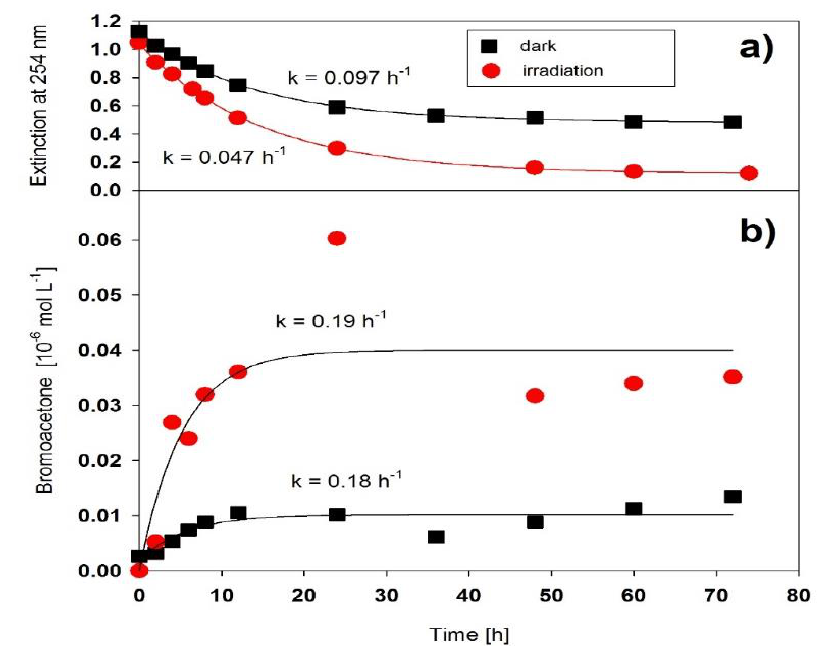
Figure 7. Time series observed in photochemical experiments inside a semi-batch reactor with an O 3 dose of 31∙10 −7 mol min −1 in an O 2 flow of 45 cm 3 min −1 . Panel a) shows the degradation of HA (17